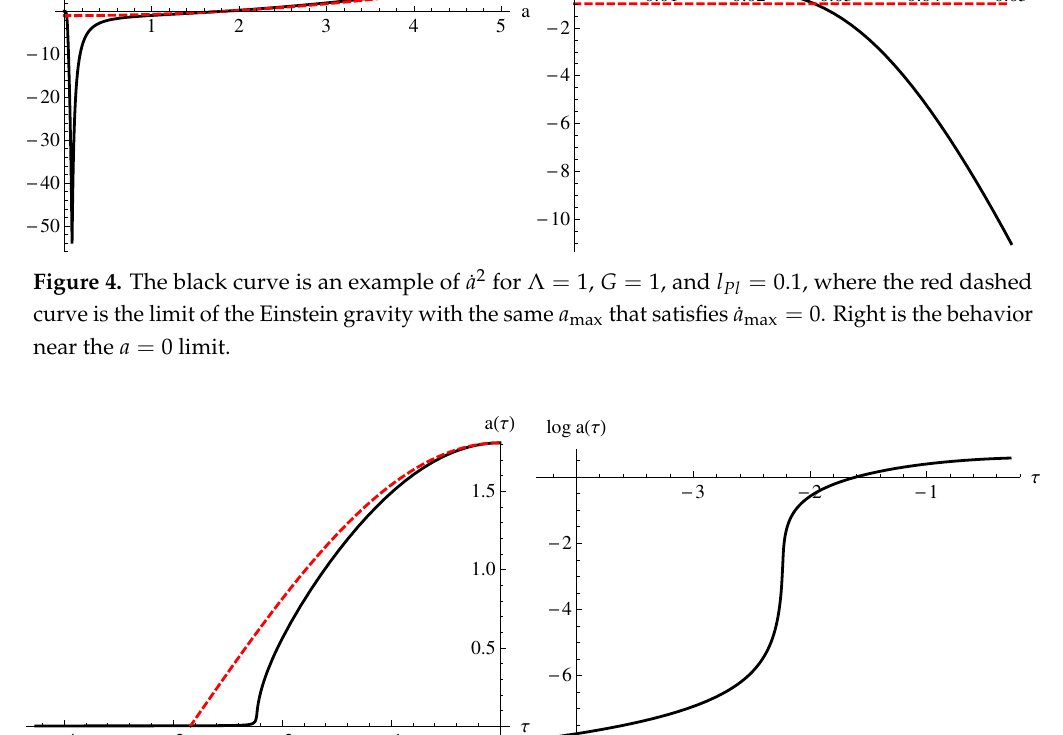
Figure 5. Left : a ( τ ) (red dashed curve is the limit of the Einstein gravity). Right : log a for small a limit. It has an infinitely long throat.